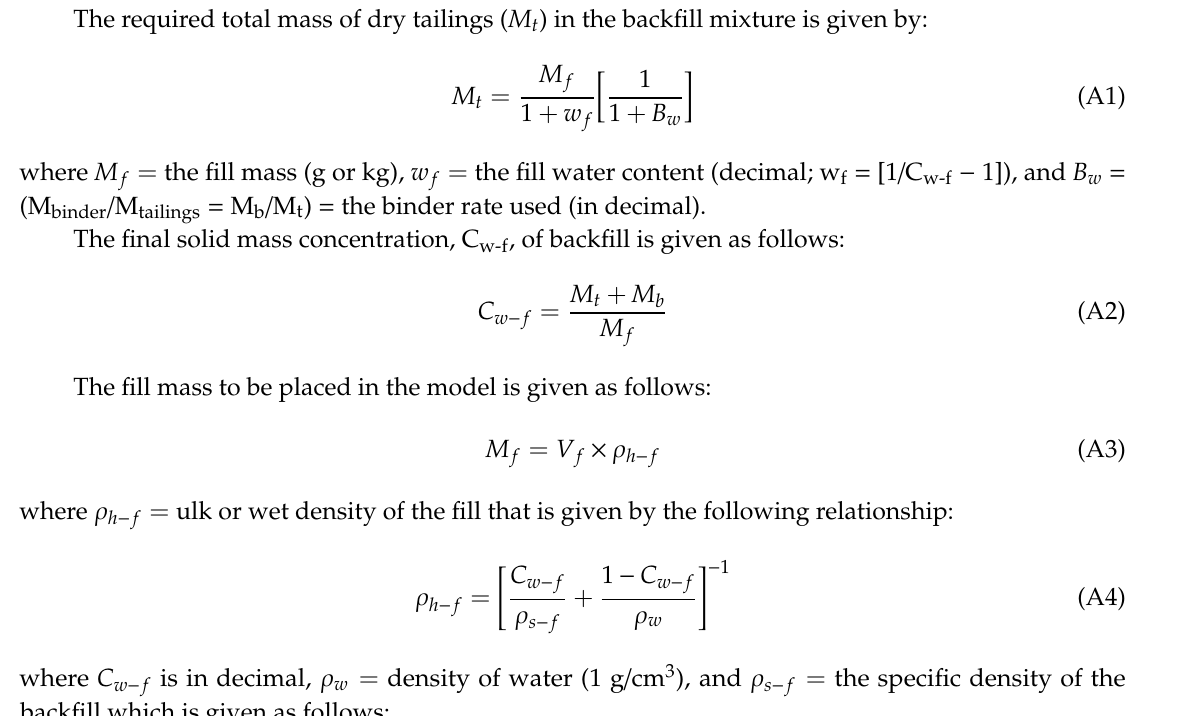
Figure A3. Calibration of the sensors of the total earth pressure at the face of the barricade (PS-D).